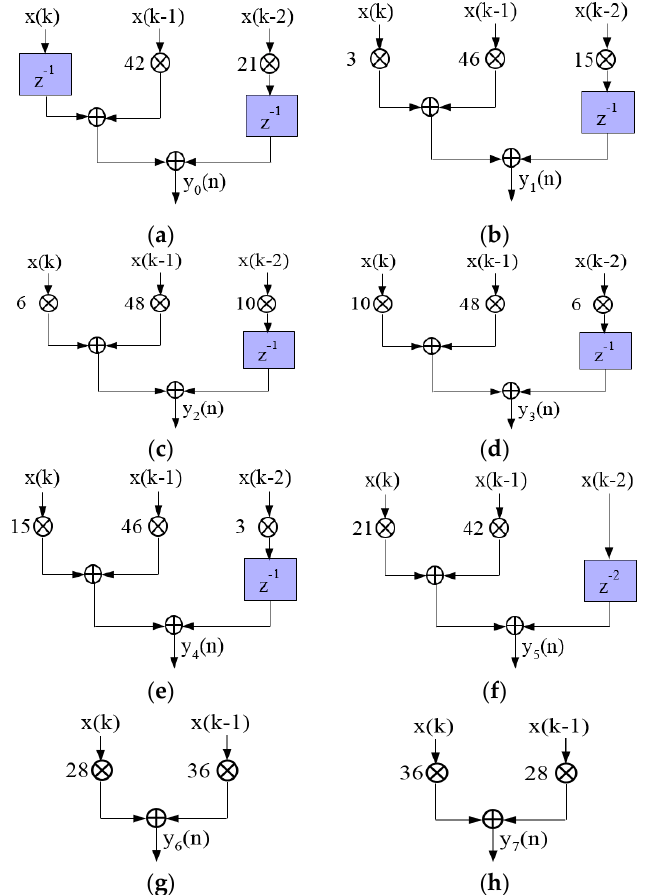
Figure 4. Optimized 8-channel parallel structure: ( a ) y 1 ( n ) ; ( b ) y 2 ( n ) ; ( c ) y 3 ( n ) ; ( d ) y 3 ( n ) ; ( e ) y 4 ( n ) ; ( f ) y 5 ( n ) ; ( g ) y 6 ( n ) ; ( h ) y 7 ( n ) 2.4. The Principle of Ultrasonic Phased Array Focusing Time Delay Based on 8× Interpolation CIC Filter Parallel Algorithm